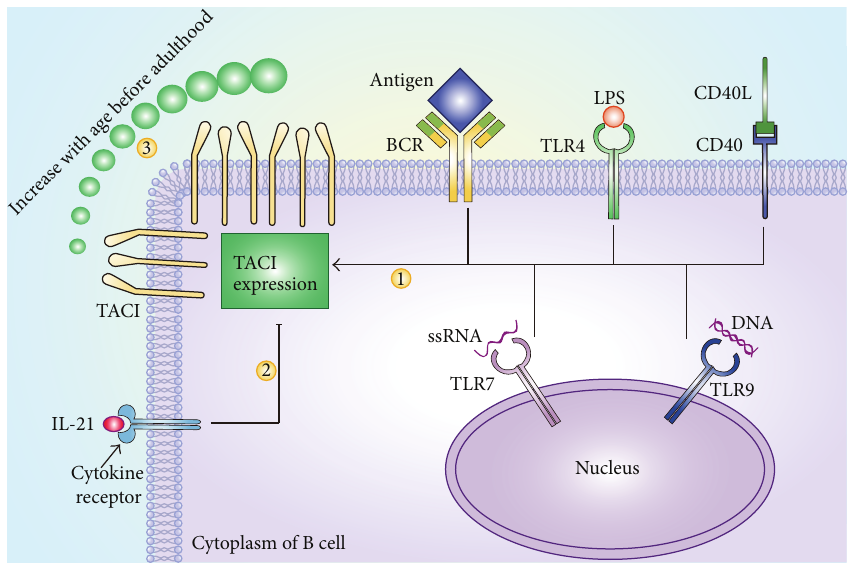
Figure 2: Regulation of TACI expression. Activation TLR4, TLR7, or TLR9 increases TACI expression in B cells. Ligation of CD40 or BCR activation also results in elevated TACI expression in B cells (1). However, IL-21 downregulates TACI expression in GC B cells (2). TACI expression in B cells increases with age before adulthood